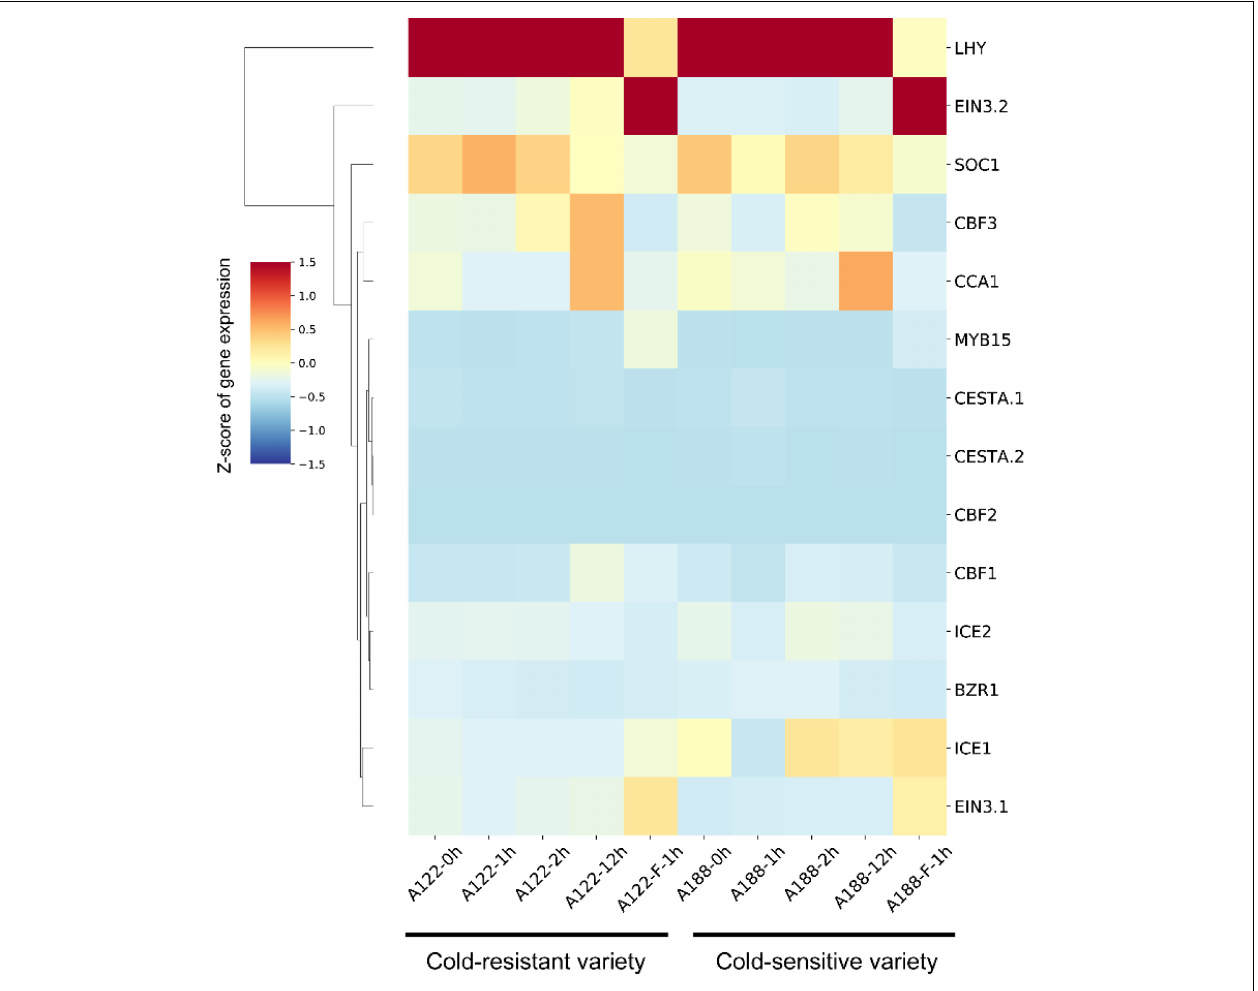
FIGURE 8 | Hierarchical cluster analysis of 14 ICE-CBF-COR genes in A122 and A188. The values in the heatmap represent the z -scores of fragments per kilobase million (transcription level) in different samples. The red and blue colors indicate high and low expression levels,